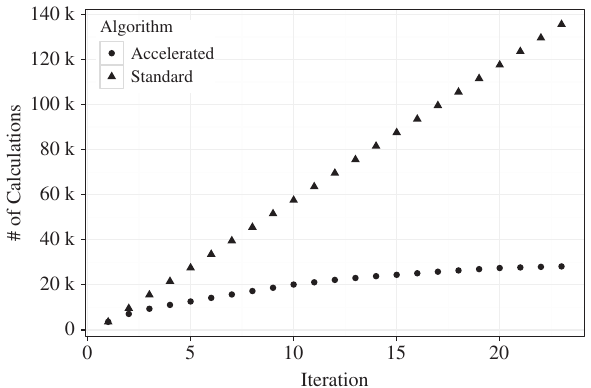
Figure 8. Acceleration Results of Experiment